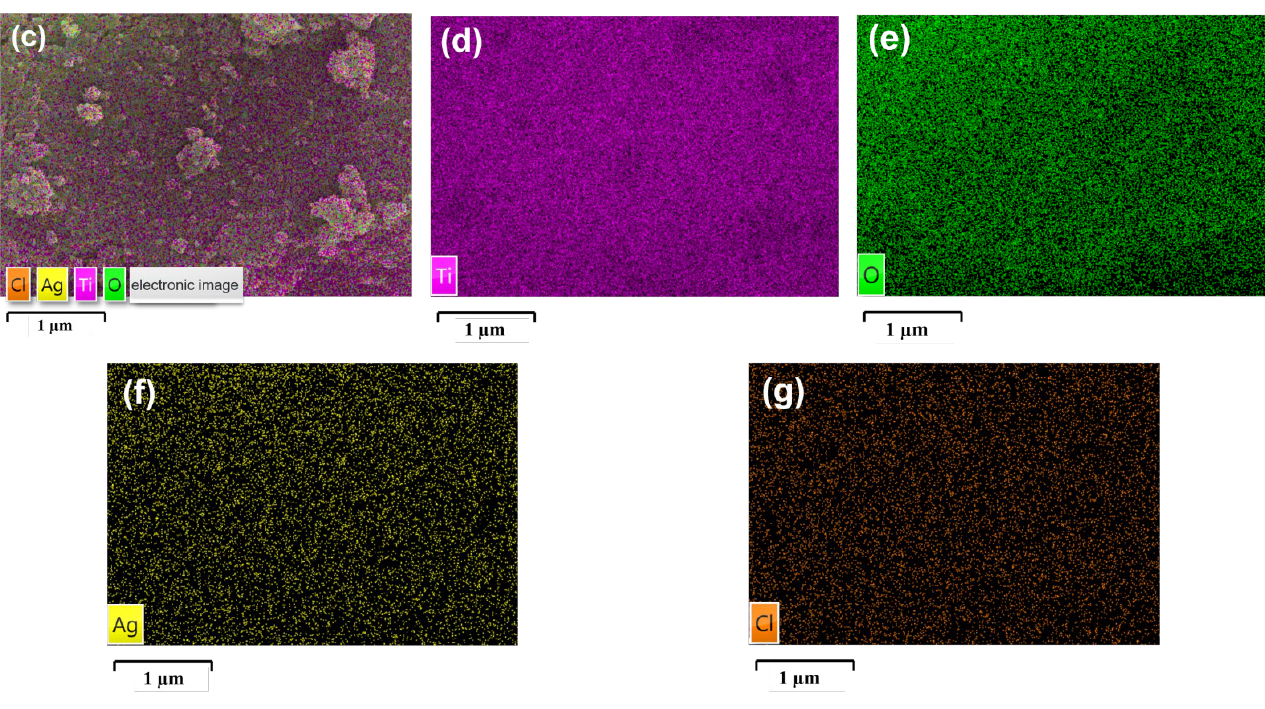
Figure 2. SEM images of ( a ) pure TiO 2 and ( b ) 4%Ag-TiO 2 and SEM mapping of ( c – g ) 4%Ag-TiO 2 . Figure 3 shows TEM and HRTEM images of pure TiO 2 (a,c) and 4%Ag-TiO 2 (b,d). The single-crystal grain sizes of pure TiO 2 and 4%Ag-TiO 2 were both around 10–20 nm. The interplanar spacings in Figure 3c, 0.35 nm, 0.32 nm, and 0.29 nm, correspond to the (101) crystal plane of anatase, the (110) crystal plane of rutile, and the (121) crystal plane of brookite [28,30,37]. Consistently with the XRD results, the pure TiO 2 was a three-phase coexisting structure of anatase, rutile, and brookite. The interplanar spacing marked in Figure 3d was 0.35 nm, which corresponds to the (101) crystal plane of anatase. The interplanar spacings of 0.23 nm and 0.28 nm were indexed to the (111) crystal plane of elemental Ag and the (200) crystal plane of AgCl [38].